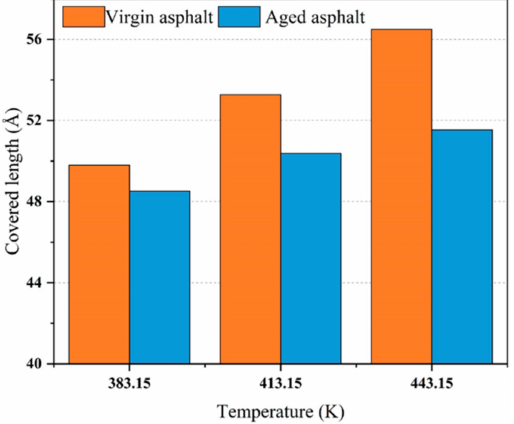
Figure 8. Covered